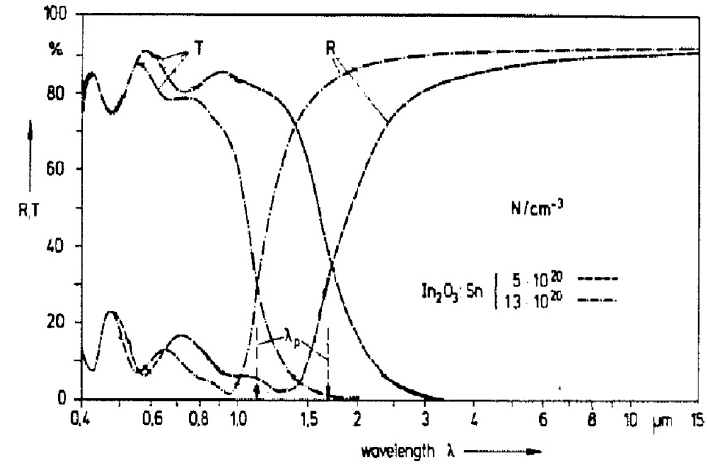
Figure 6. The transmittance and reflectance of In 2 O 3 :Sn prepared by the hot spray technique [76].